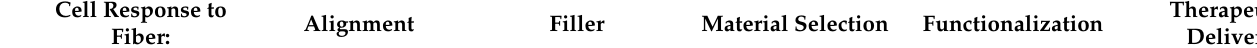
Filler Material Selection Functionalization